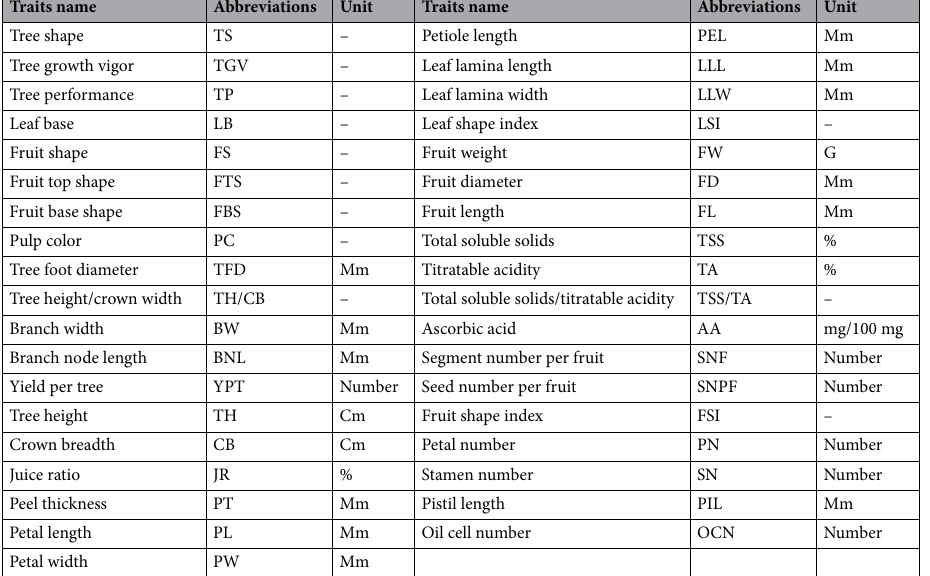
Table 1. Traits abbreviations and units.